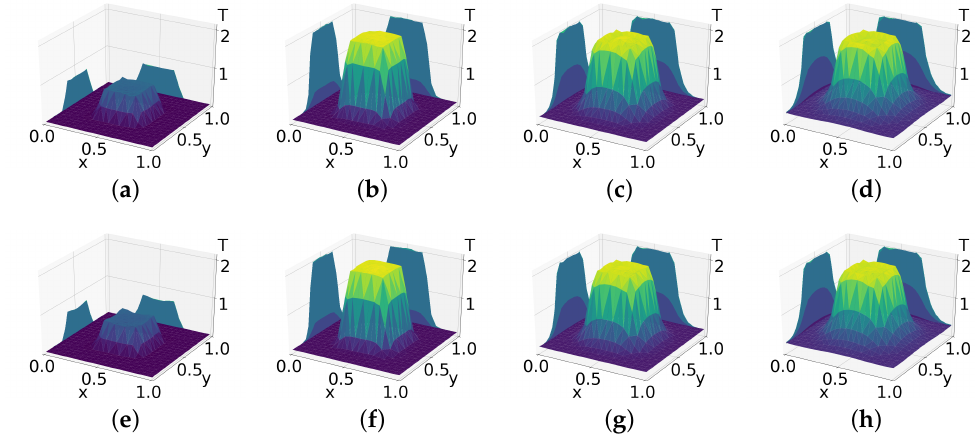
( t , x ) , ξ , t , x )] of CCHTMPC by τ = 5 × ( ˆ t 1 ,ˆ t 1 + H (cid:48) ]